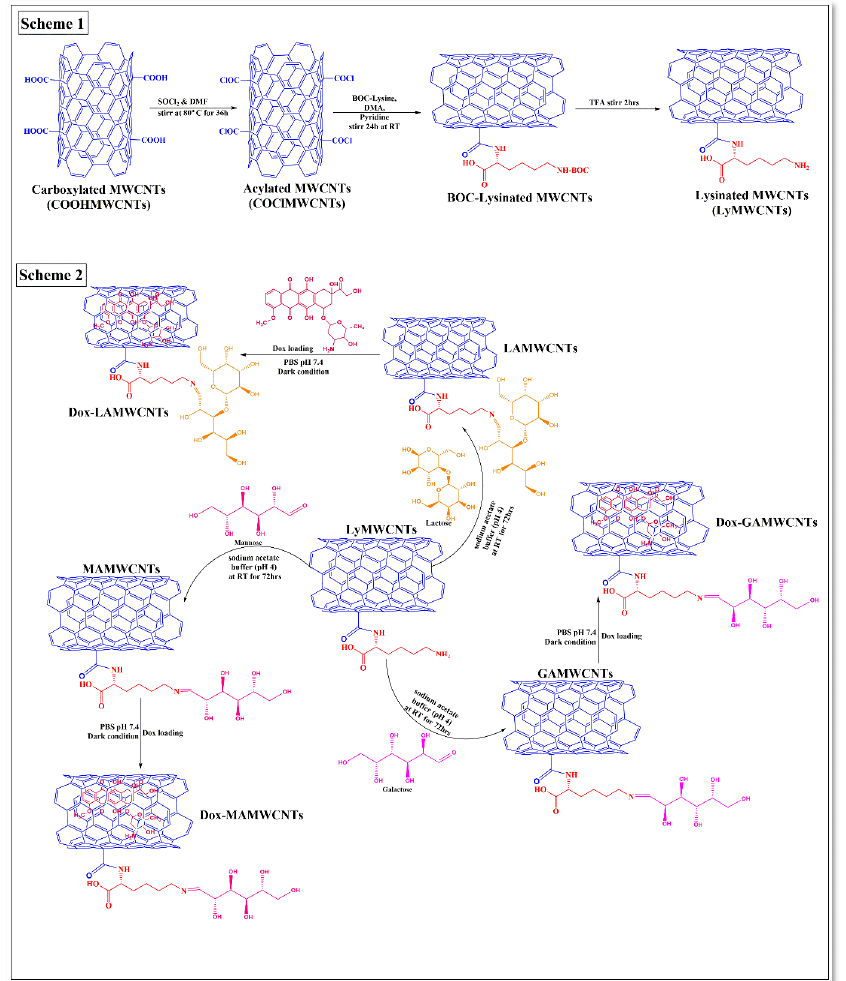
Figure 1. Schematic illustration of the synthesis of conjugated MWCNTs. Scheme 1: preparation of lysine conjugated with acylated MWCNTs. Scheme 2: Lysinated MWCNTs covalently modified with carbohydrate ligands and the loading of Dox.